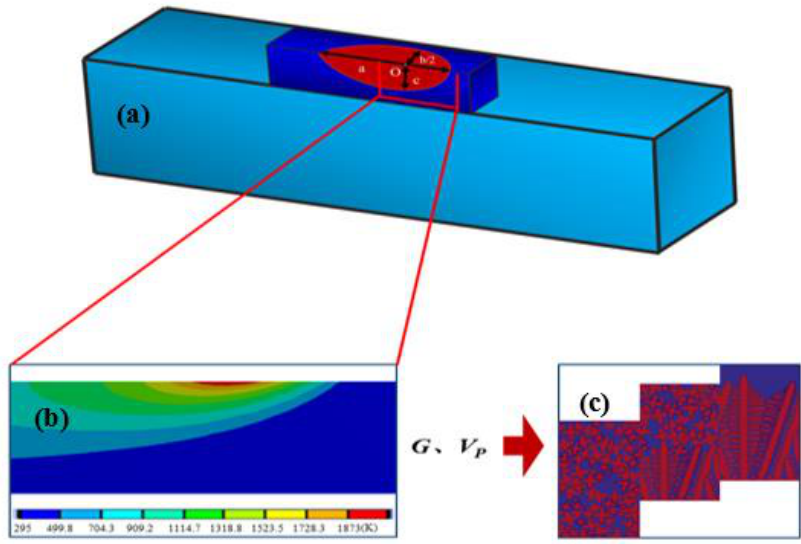
Figure 3. Schematic diagram of macro-micro coupling. ( a ) Molten pool model, ( b ) Molten pool temperature distribution, ( c ) Micro dendrite structure.